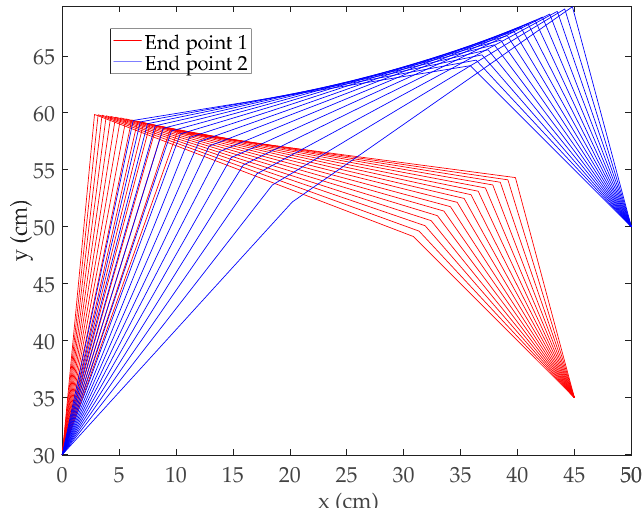
Figure 11. Redundant space of different end points.